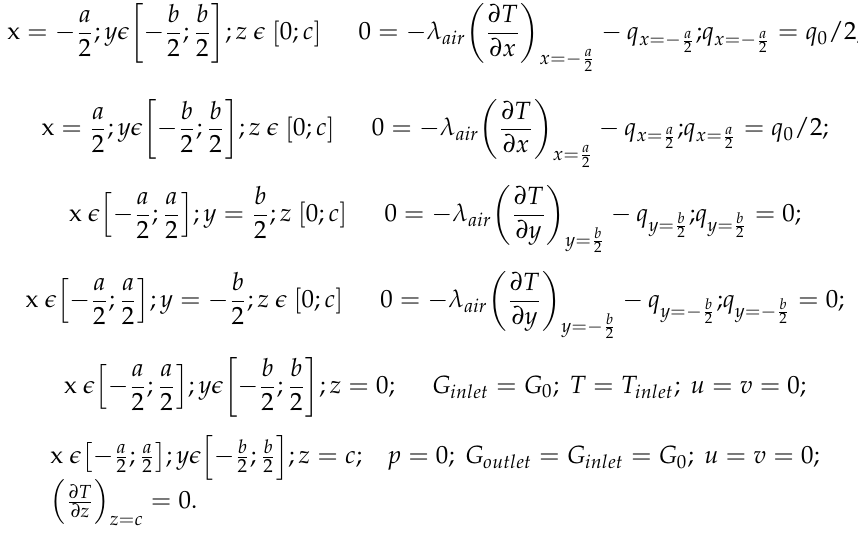
Table 2. Plan for performing the numerical experiment with two-sided heat input. Heat Flow Density, W/m 2